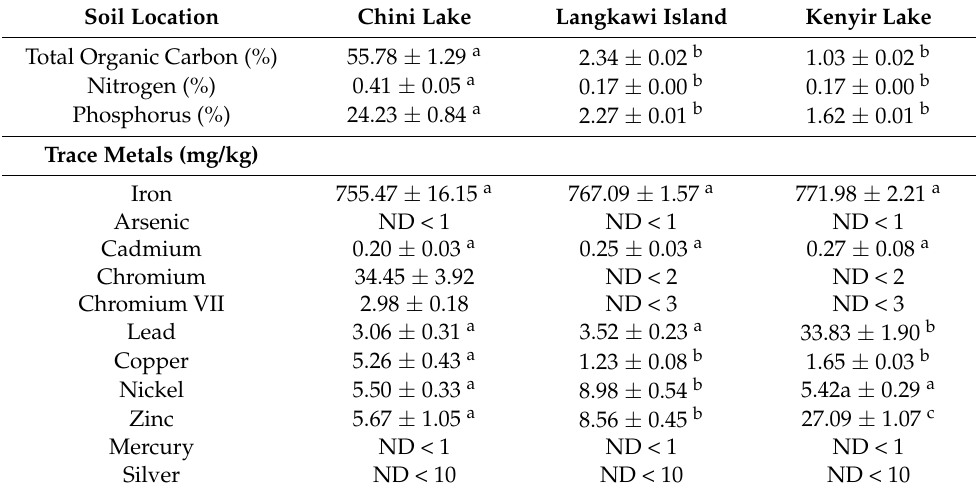
Table 2. Chemical Analysis of